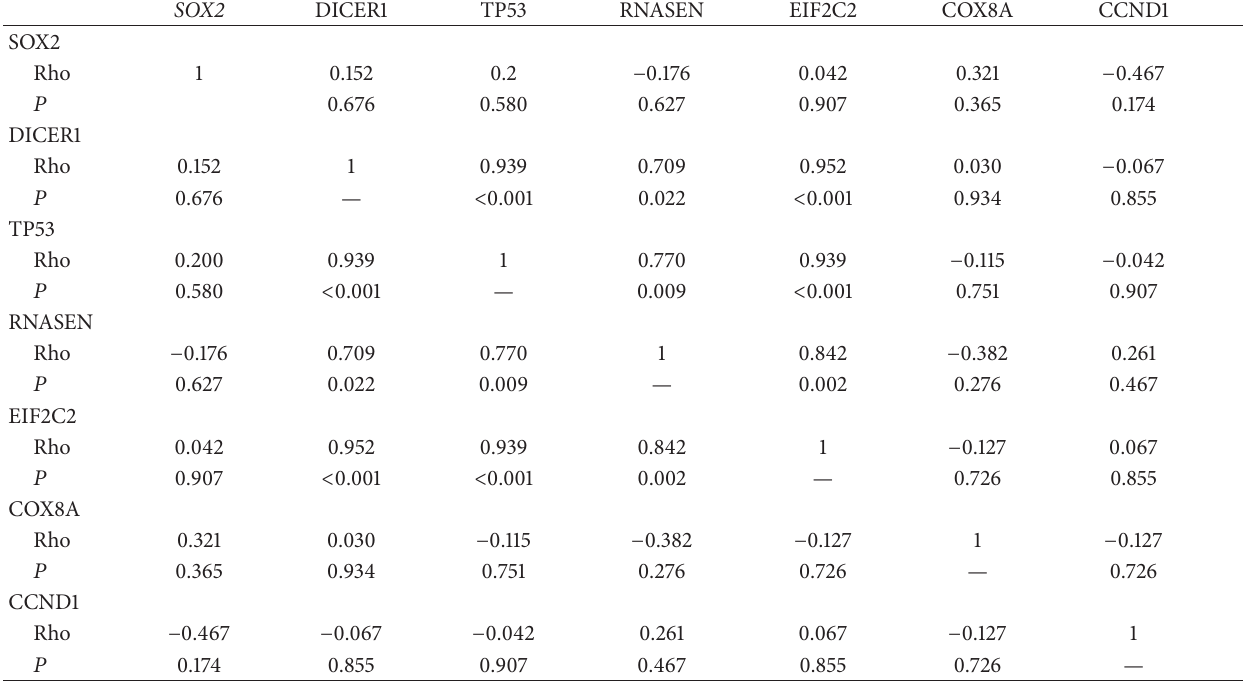
Table 9: Spearman two-tailed test correlations between basal gene expressions (as reported in Supplementary Table 1) among SW1736,